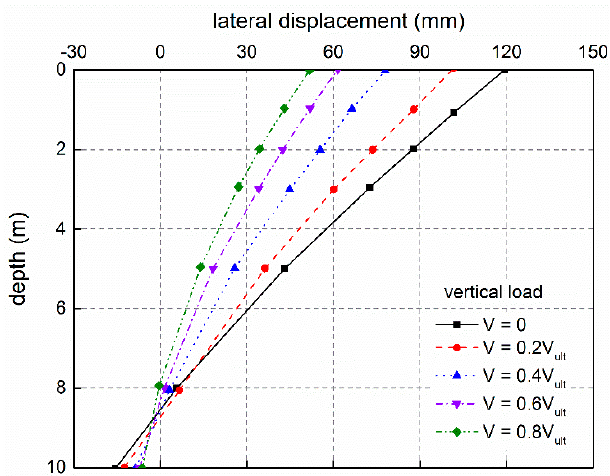
Figure 4. Variation in lateral displacement along a pile in sand for an applied lateral load of 641 kN [30]. Some numerical research disagrees with the findings of the analytical